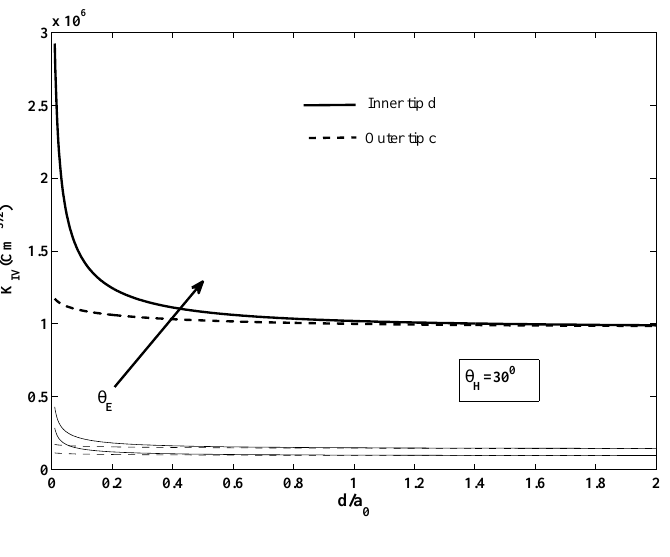
Fig. 6 EDIF versus inter-crack distance for different electric poling with fixed magnetic poling